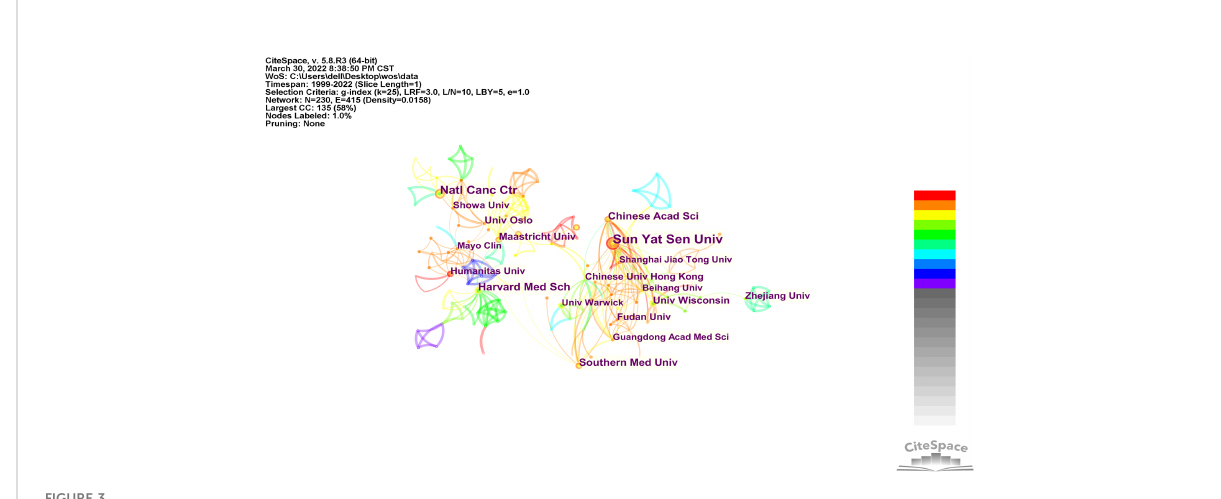
FIGURE 3 Co-institutions analysis of global research.